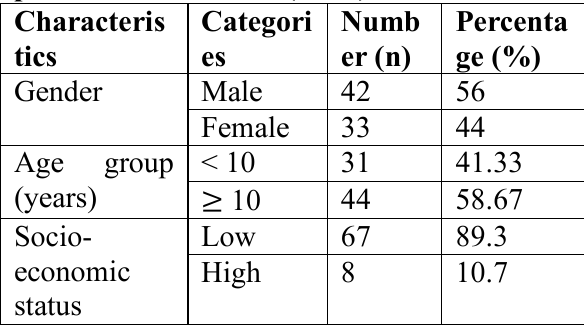
Table1: Characteristics of patients with poisonous snake bite (n=75)